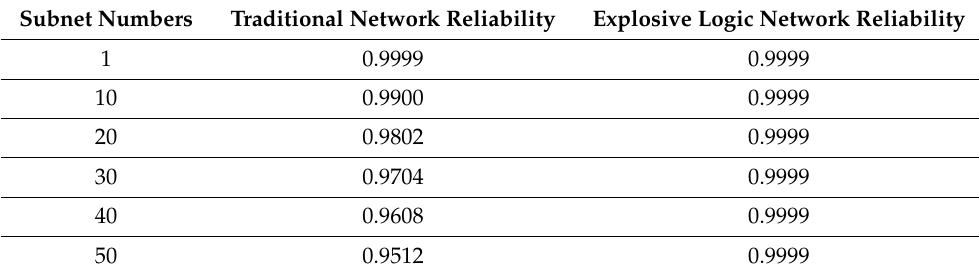
Table 5. Comparison of the reliability of two types of blasting